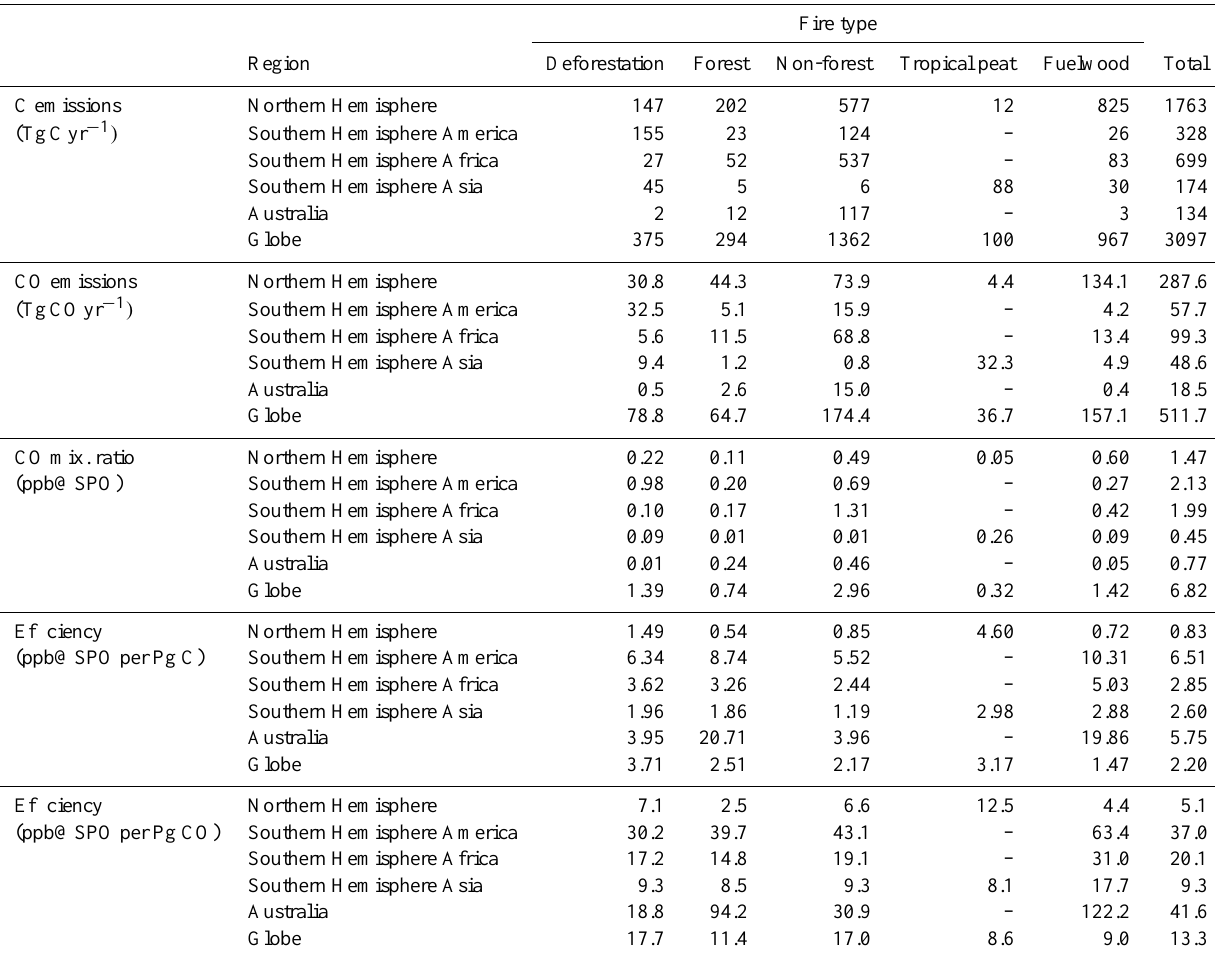
Table 1. GFED3 emissions estimates of carbon (C) and carbon monoxide (CO) for various regions and sources, the resulting CO mixing ratio at SPO, and the relative ratio between C and CO emissions and SPO mixing ratios as a measure of how much the various sources contribute to contemporary SPO mixing ratios. Tg=10 12 g, Pg=10 15 g. See also Fig.